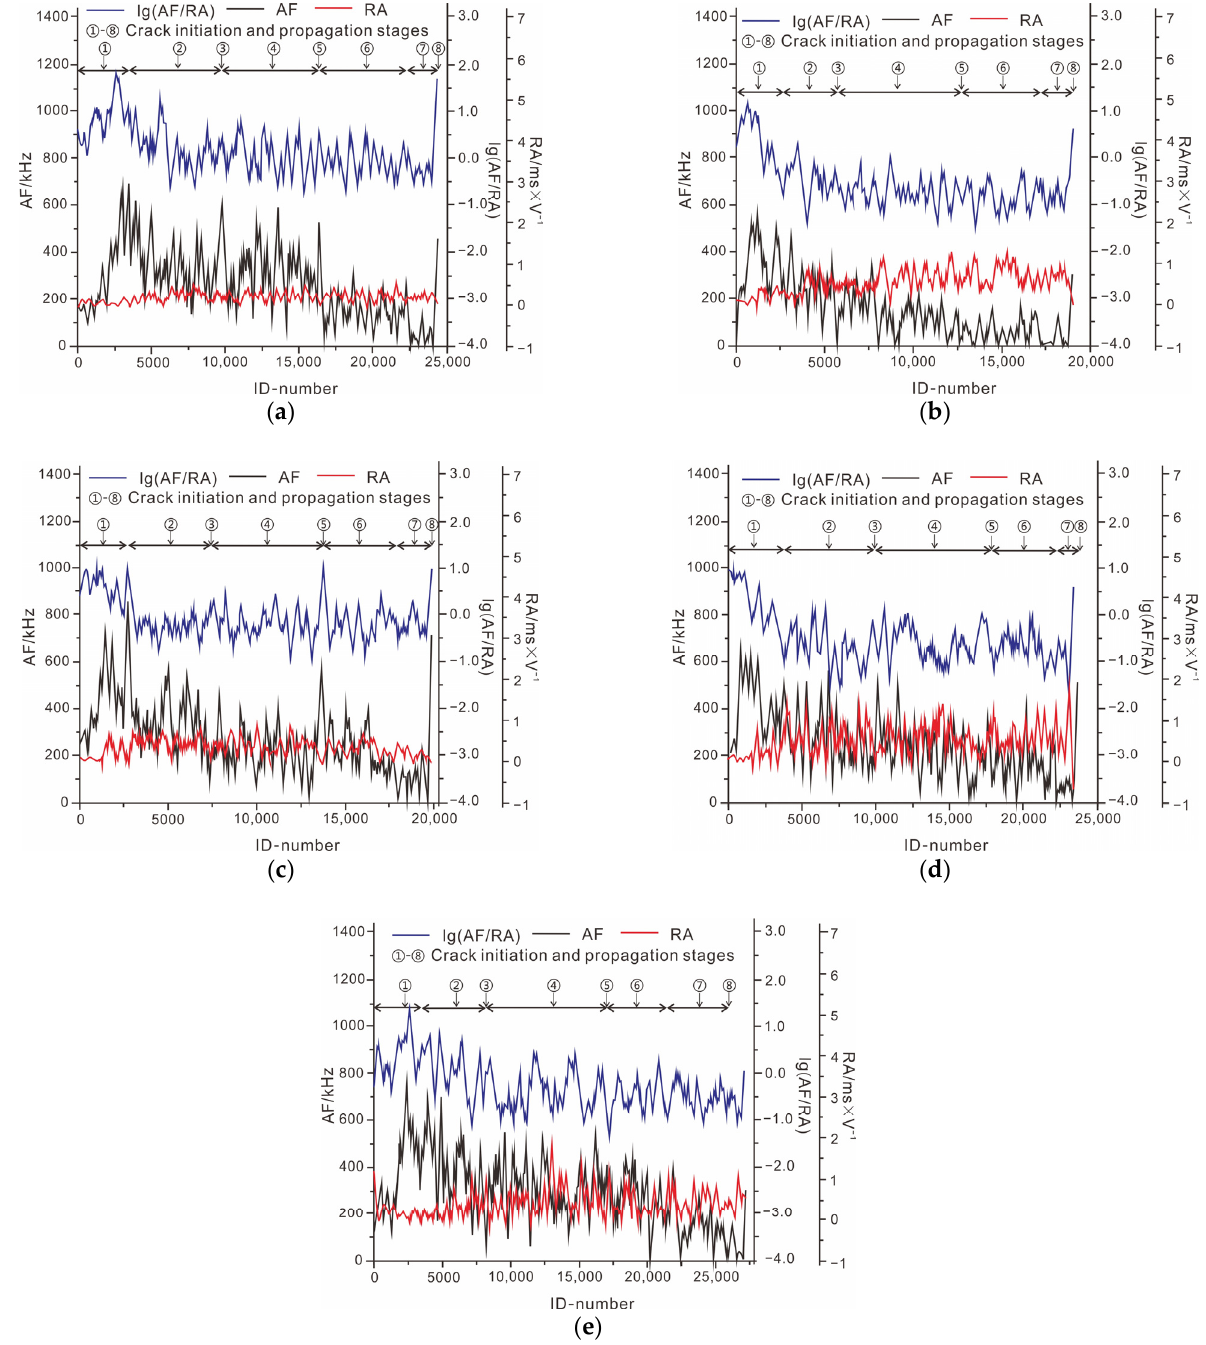
Figure 10. Parameters of the acoustic emission of rock sample with double cracks. ( a ) Curves of rock sample with conjugate double cracks; ( b ) curves of rock sample with collinear double cracks; ( c ) curves of rock sample with cross double cracks; ( d ) curves of rock sample with parallel double cracks; ( e ) curves of rock sample with intermittent double